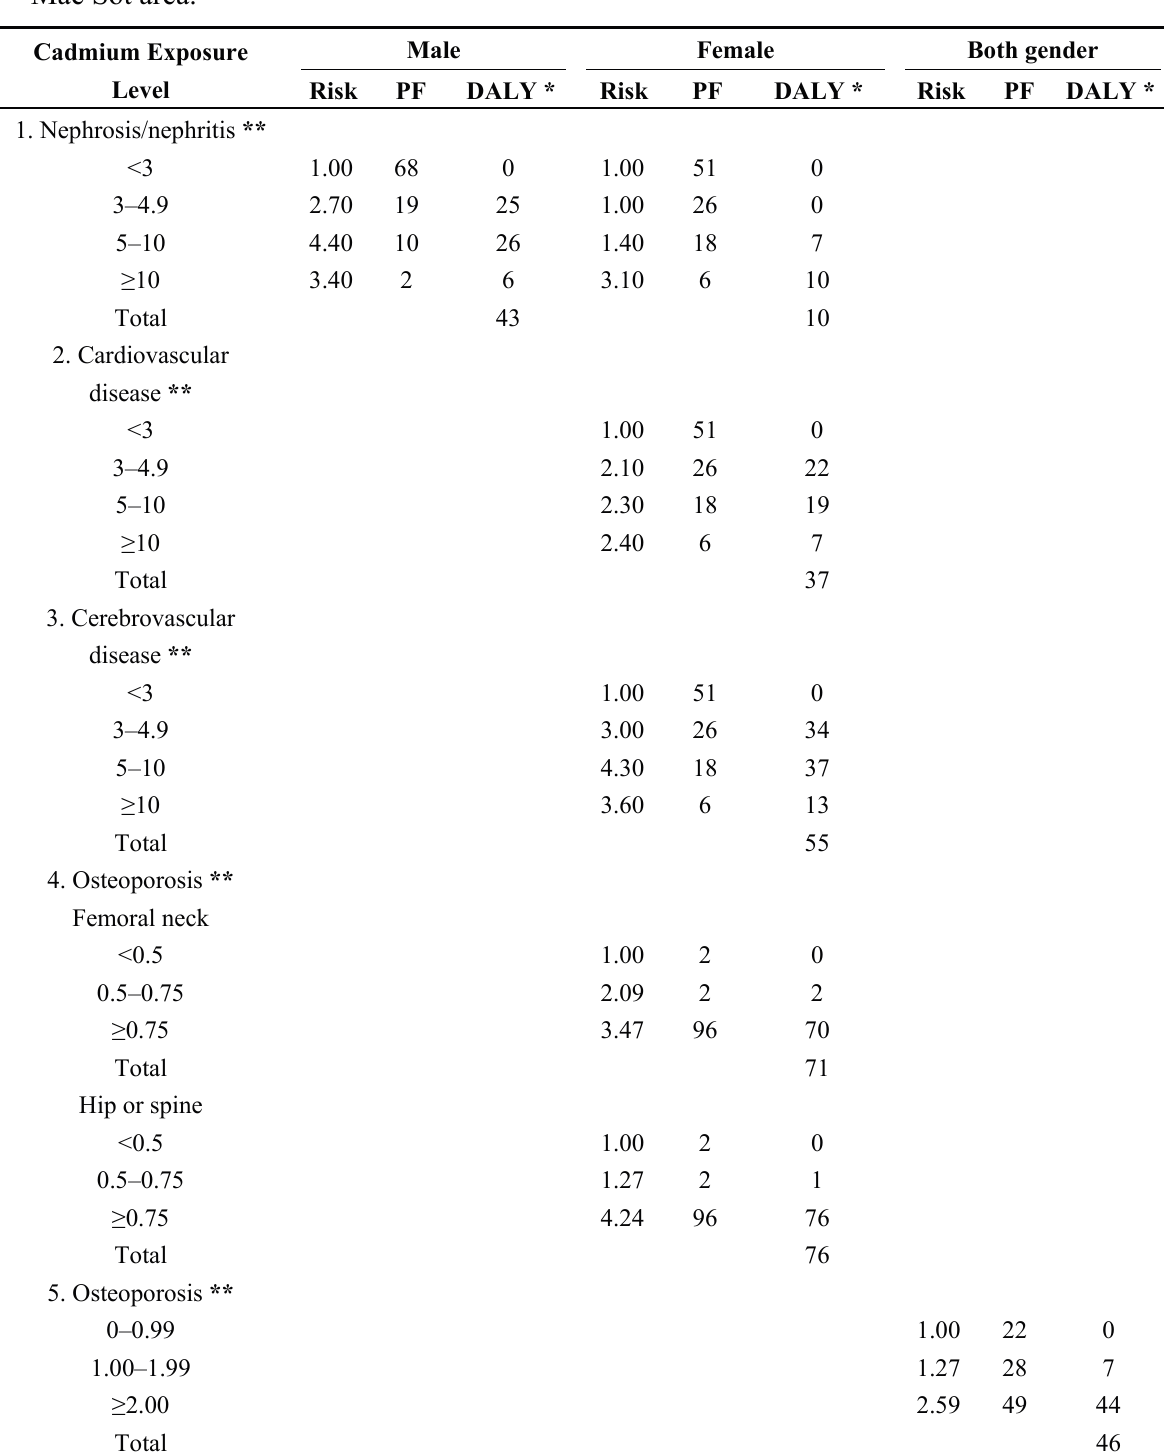
Table 4. Additional disability adjusted life years (DALYs) estimates from U-Cd in the Mae Sot